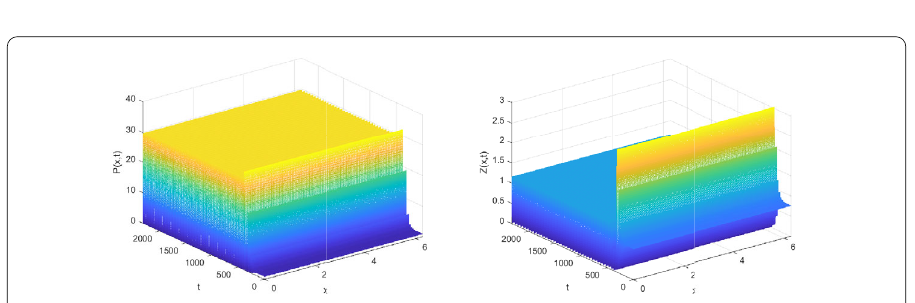
Figure 6 If τ = 5.8, the stable periodic solutions bifurcate from the equilibrium E ∗ = (0.866,0.757)